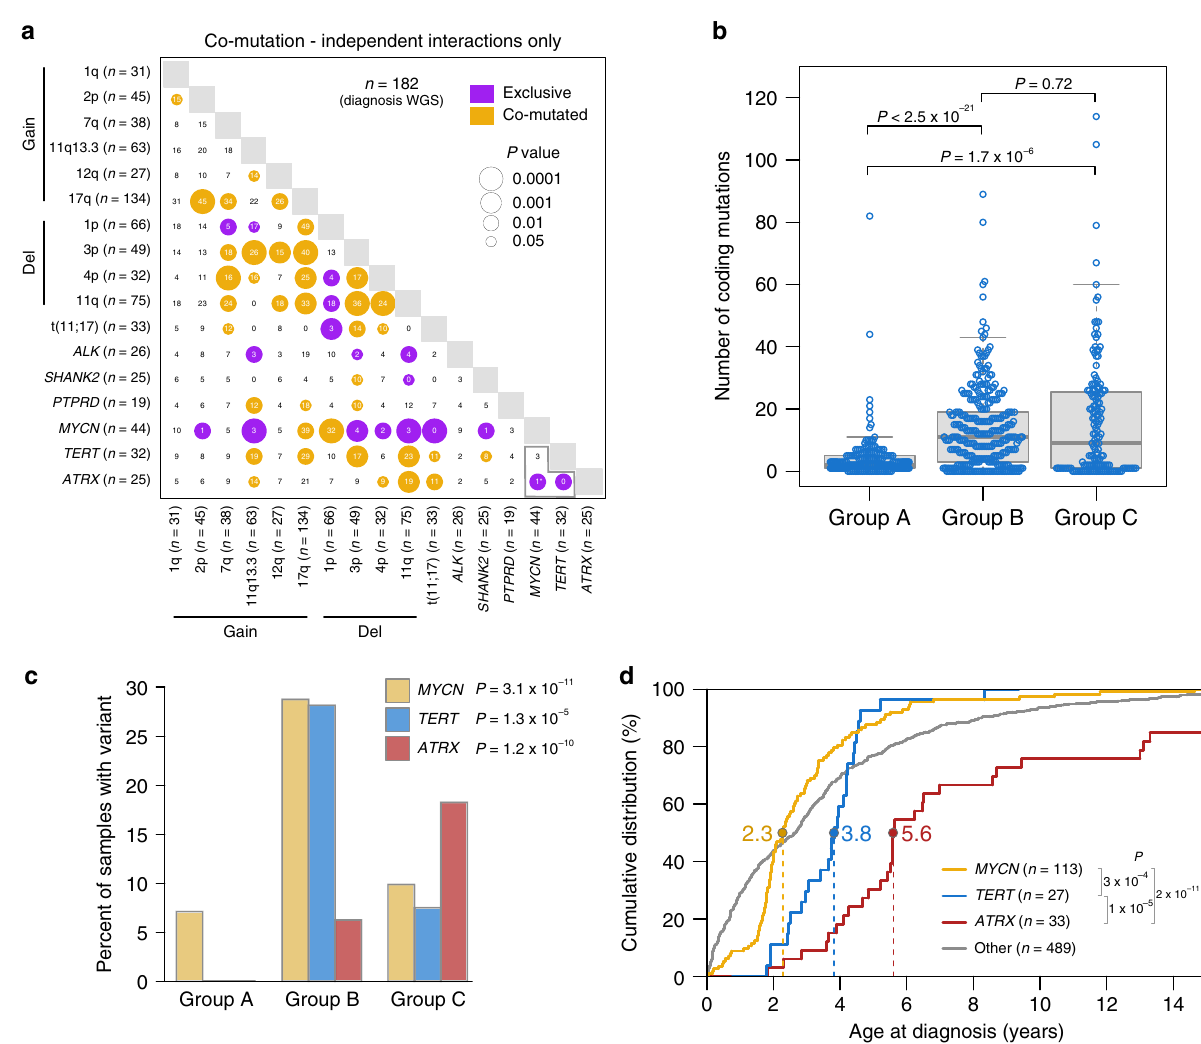
Fig. 3 Age-associated genetic alterations. a Mutual exclusivity and co-occurrence in diagnosis samples with WGS ( n = 182). When two alterations co- occurred in a sample, the alterations were excluded from analysis if the two alterations were joined by an SV (non-independent). P values are by two-sided Fisher ’ s exact test. Asterisk, female with ATRX and MYCN alterations. Gold, signi fi cant co-occurrence; purple, mutually exclusivity. Circle size is inversely related to P value. Gains and deletions (del) include segmental chromosome alterations and exclude whole-chromosome alterations. b Boxplot showing coding mutation burden, including 662 diagnosis samples with WGS or WES; a single outlier in group B had 200 mutations (sample numbers: group A, 197; B, 313; and C, 152). Box, interquartile range (25th to 75th percentile); middle bar, median. Whiskers are described in R boxplot documentation (a 1.5 × interquartile range rule is used). Each point represents one sample and P values are by two-sided Wilcoxon rank-sum test. c Percentage of diagnosis samples with indicated gene alterations by age group; n = 662, 182, or 499 for MYCN (WGS or WES samples), TERT (WGS samples), or ATRX (WGS samples or WES samples with ATRX targeted sequencing), respectively. P values are by two-sided Fisher ’ s exact test comparing prevalence among age groups. d Empirical cumulative distribution function showing diagnosis age ( x -axis) of patients with alterations in MYCN (gold), TERT (blue), ATRX (red), or none of these alterations (gray, other). Five patients with both MYCN and TERT alterations and one with both MYCN and ATRX were included in the other group. 662 diagnosis samples with WGS or WES were analyzed. Y -axis represents the percent of patients in each group diagnosed at or before the age indicated on x -axis. P values are by two-sided Wilcoxon rank-sum test. Dotted lines indicate median age in the mutated group. Several ATRX -mutant patients were diagnosed at >15 years; hence the ATRX curve does not reach 100%. If only WGS data were considered, the MYCN median age was 2.5, the TERT and ATRX median ages did not change, and the P value comparisons shown were P < 0.003. Source data are provided as a Source Data fi